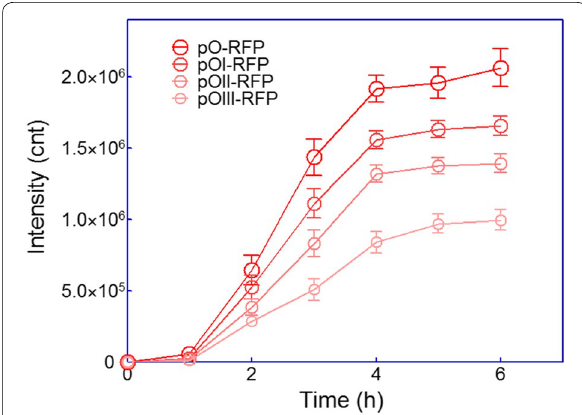
Fig. 3 Effect of rare codons in ORF1 on mCherry expression in ORF2 in E. coli strain Rosetta(DE3)pLysS. Rosetta(DE3)pLysS harboring various plasmids were grown for 6 h in LB media after 0.5 mM IPTG induction. mCherry fluorescence of bacterial cells suspension was measured every hour using a Luminar fluorescence spectrometer. Fluorescence intensity values were normalized using the absorbance at 600 nm. Data are representative of three independent experiments and values are expressed as mean ±